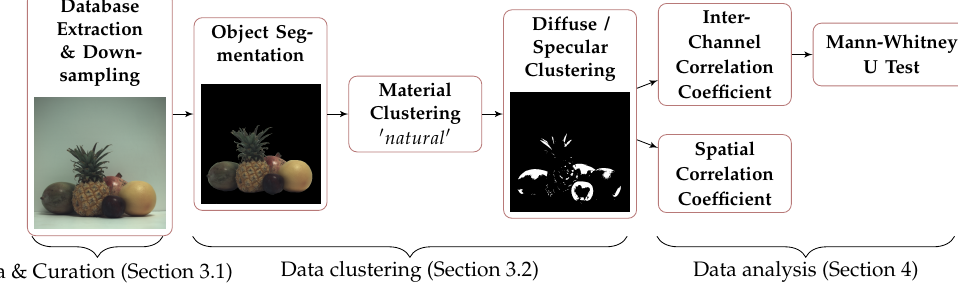
Figure 1. Experimental pipeline. “Data & Curation”, “Data clustering”, and “Data analysis” refer to the Sections 3.1, 3.2 and 4.